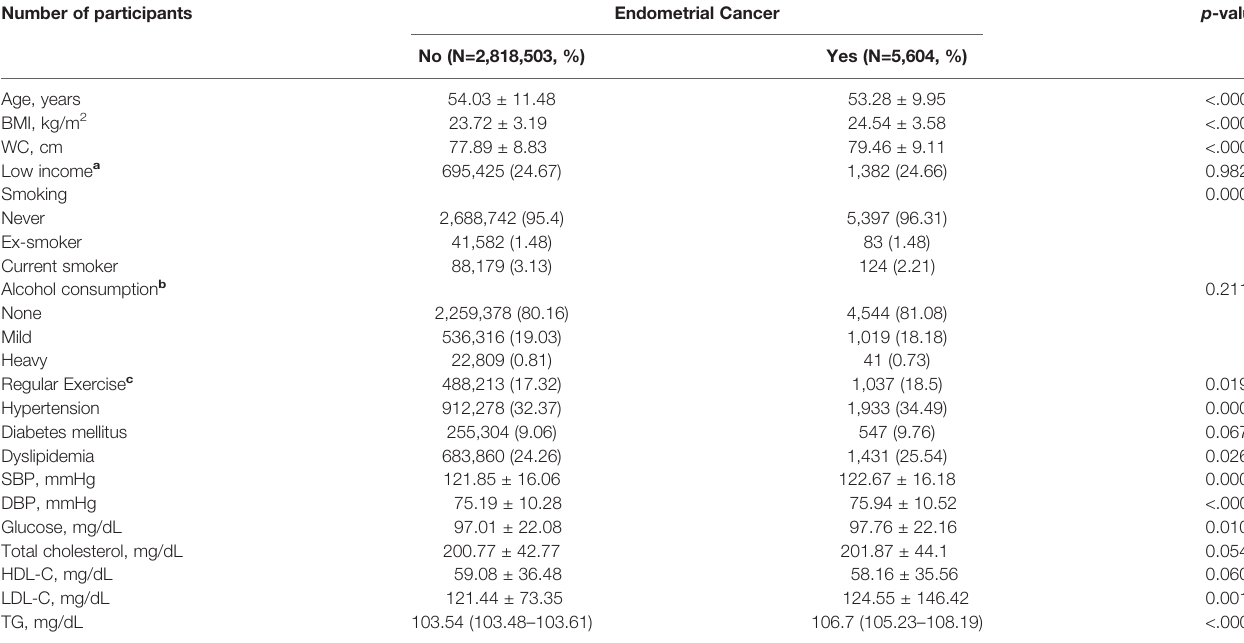
TABLE 1 | Baseline characteristics of the study population. Number of